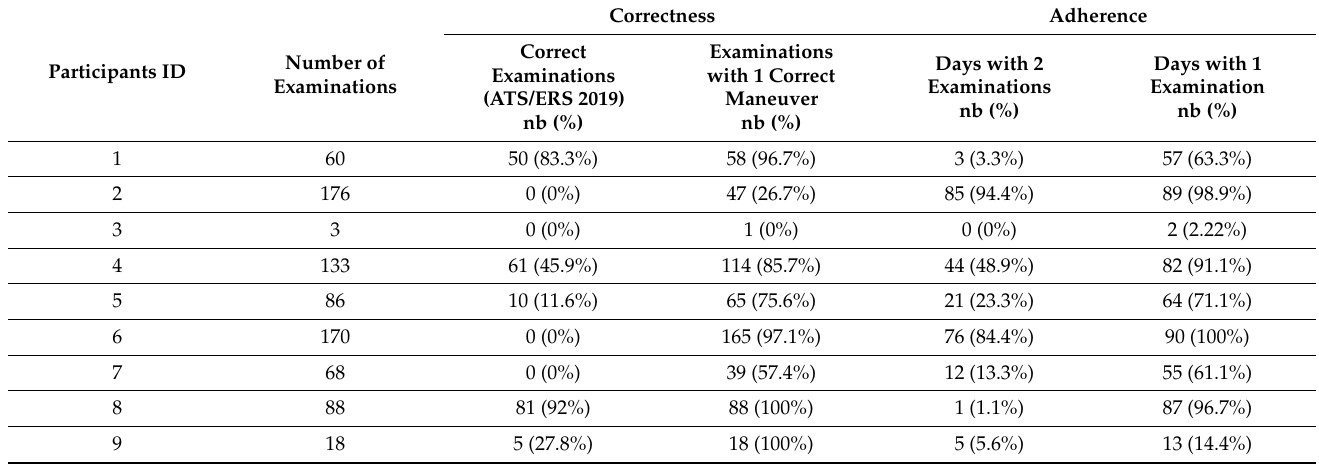
Table 2. Compliance with home e-spirometry for individual